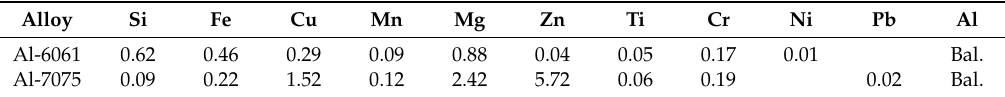
Table 1. Chemical composition of Al alloys in weight % [16,17]. (Bal: Balance)